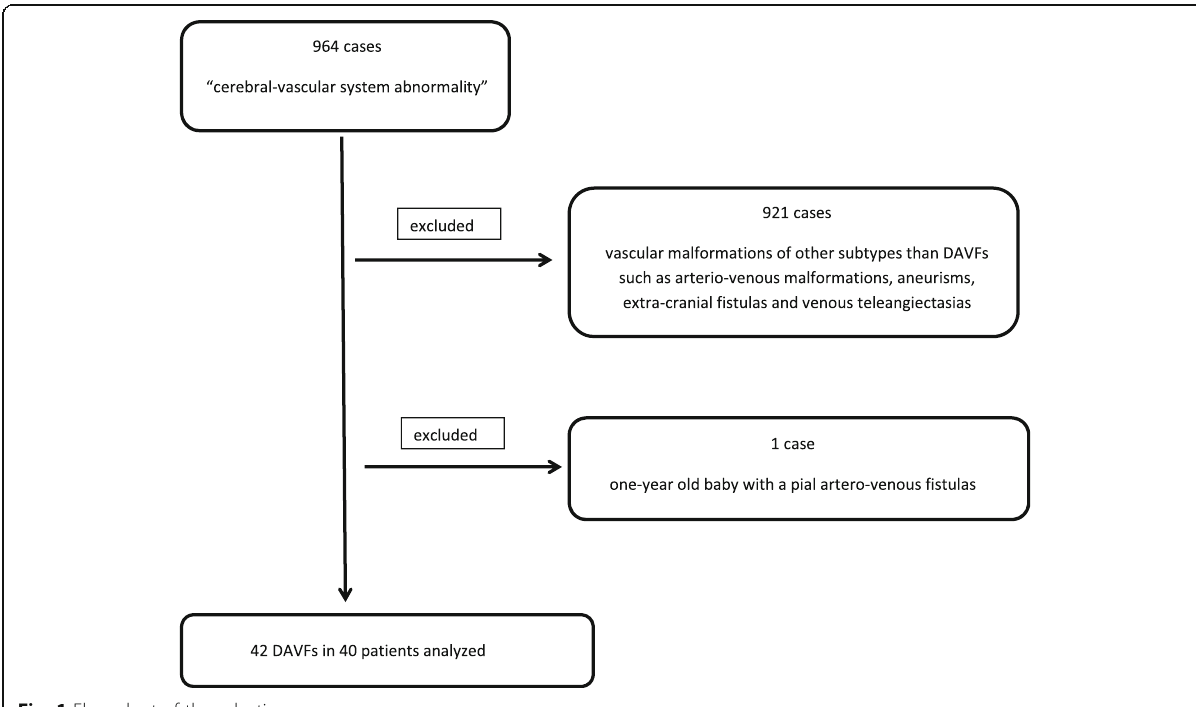
Fig. 1 Flow-chart of the selection